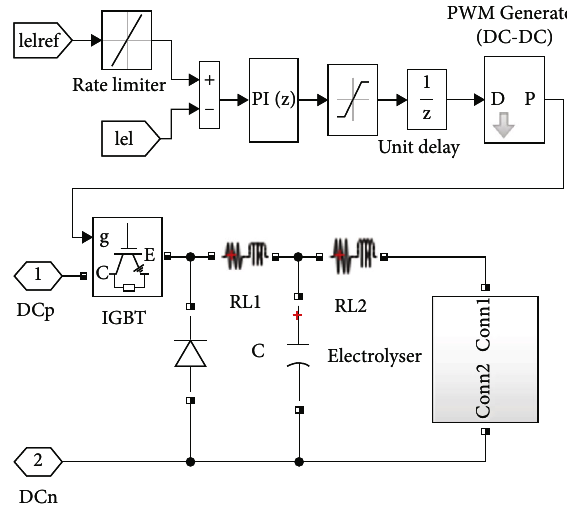
Figure 5: DC-DC buck converter and current